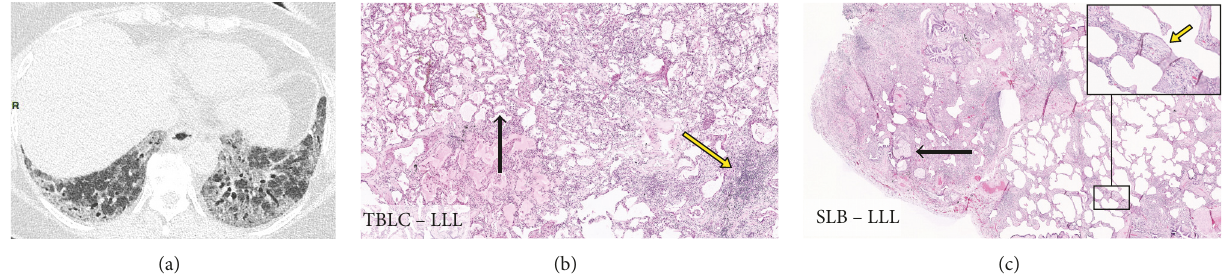
Figure 3: Illustration of the additional information obtained from surgical biopsy after cryobiopsies showing an NSIP pattern. A 75-year- old woman with idiopathic interstitial pneumonia had a chest CT scan showing an inconsistent UIP pattern (subpleural and basal reticular opacities, traction bronchiectasis, and ground glass opacities with an extent greater than reticular abnormalities without honeycombing) (a). TBLCs were performed in the left lower lobe and the pathological analysis identified an NSIP pattern (hematoxylin and eosin staining, magnification × 40) (b). The NSIP pattern was characterized by the presence of an interstitial septal thickening preserving the alveolar architecture, black arrow, with chronic inflammatory infiltrate, red arrow. Neither honeycombing nor fibroblastic foci were observed. A surgical lung biopsy was then performed in the same patient, in the same lobe (left lower lobe) showing a UIP pattern (hematoxylin and eosin staining, magnification × 40) (c). The photomicrography shows the presence of fibrotic changes with honeycombing (black arrow), heterogeneous architectural destructions and fibroblastic foci (enlargement and red arrow, magnification × 200). Those features were not observed on the